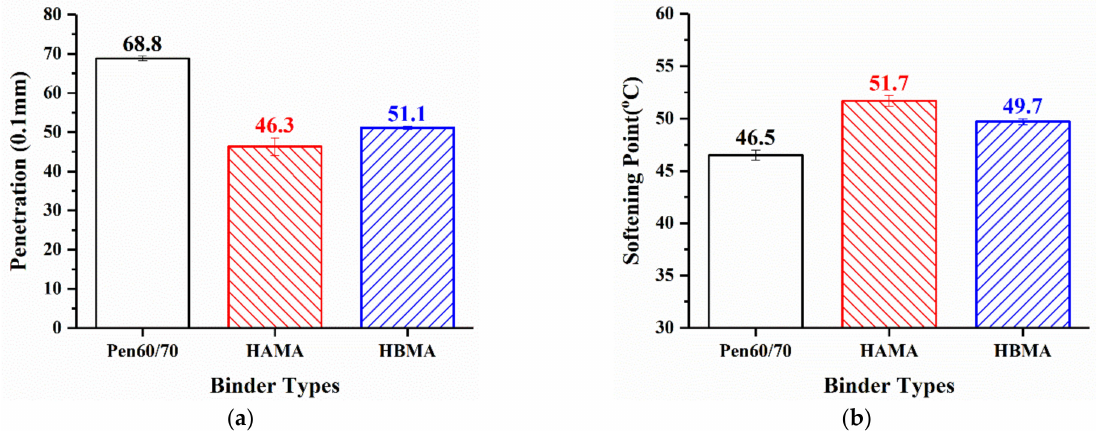
Figure 4. Conventional binder test results: ( a ) penetration and ( b ) softening point.